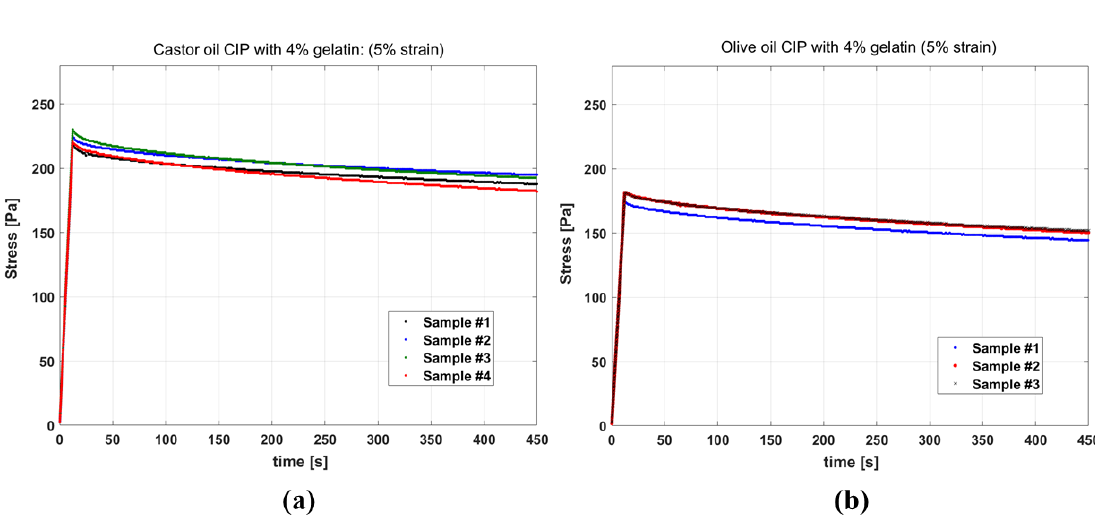
Figure 4. Stress relaxation curves for phantoms having: ( a ) channels filled with castor oil ( b ) channels filled with olive oil, all resulting from 5% strain. For castor oil, the test results of four samples and for olive oil the test results for three samples are presented.